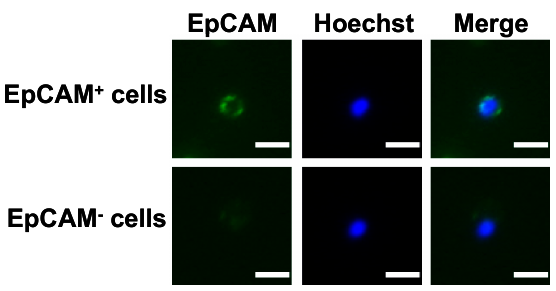
Figure 1. Schematic representation for the fluorescence images of EpCAM + and EpCAM − cells from individuals with advanced or metastatic HCC. The CD45 + -depleted cell populations that were positive and negative for EpCAM were defined, respectively. Positive staining of Hoechst 33,342 (blue) indicates the presence of intact nucleated cells. Bar =10 µm.